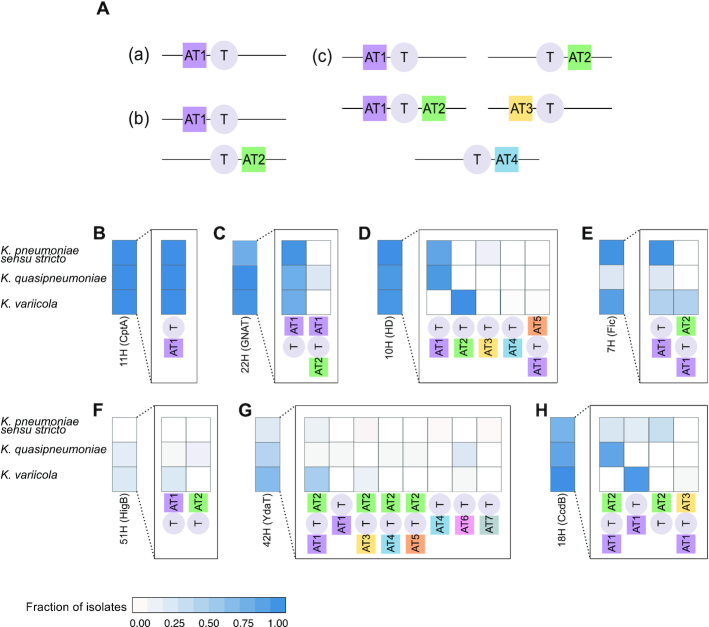
Diversity in the observed operon structures for the different toxin categories. (A) Examples of range of antitoxins and possible operon structures for a toxin (a) toxin group found in a single structure with a single antitoxin group (b) toxin group found in two different structures with two different antitoxin groups (c) toxin group found in five different structures with four different antitoxin groups. (B–H) Fraction of isolates from each Klebsiella pneumoniae species complex possessing each of the operon structures of seven example toxin groups: (B–D) ubiquitous, (E and F) species associated, (H) sporadically distributed.